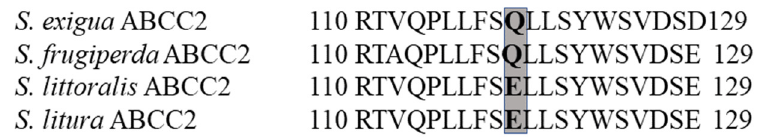
Figure 9. Alignment of a 20 amino acid sequence of ABCC2 from four Spodoptera species, presence of a glutamine or glutamic acid at position 119. Genbank accession number, S. exigua AIB06822, S. frugiperda AUO38740, S. littoralis , S. litura XM_022967434.